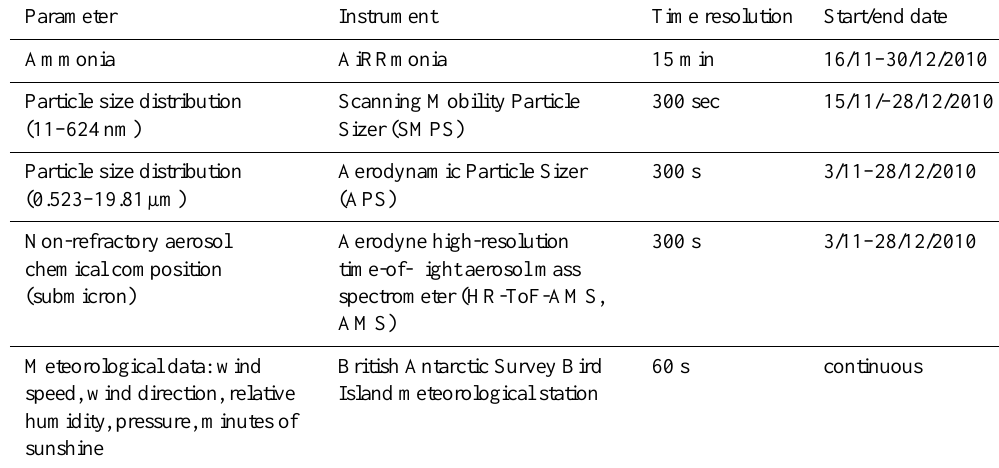
Table 3. Continuous measurements of aerosol parameters, ammonia and meteorological data at the Bird Island research